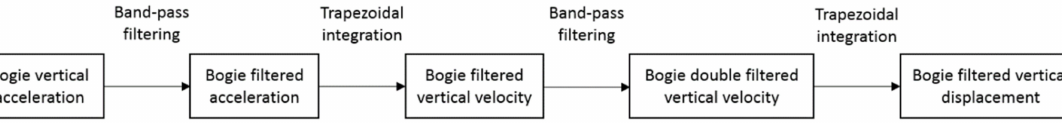
Figure 6. The integration process.